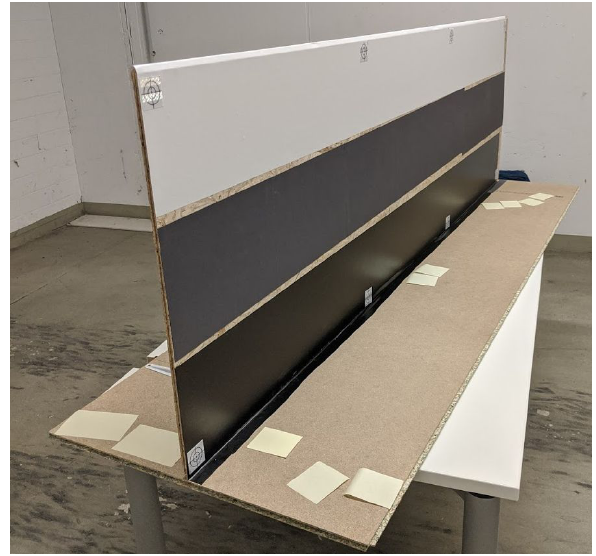
Figure 2. Wooden board with white, grey and black surface materials. The reflective tape markers along the edges are used for the tachymetry. The image shows the board at an offset of approximately 20 ◦ with respect to the ranging